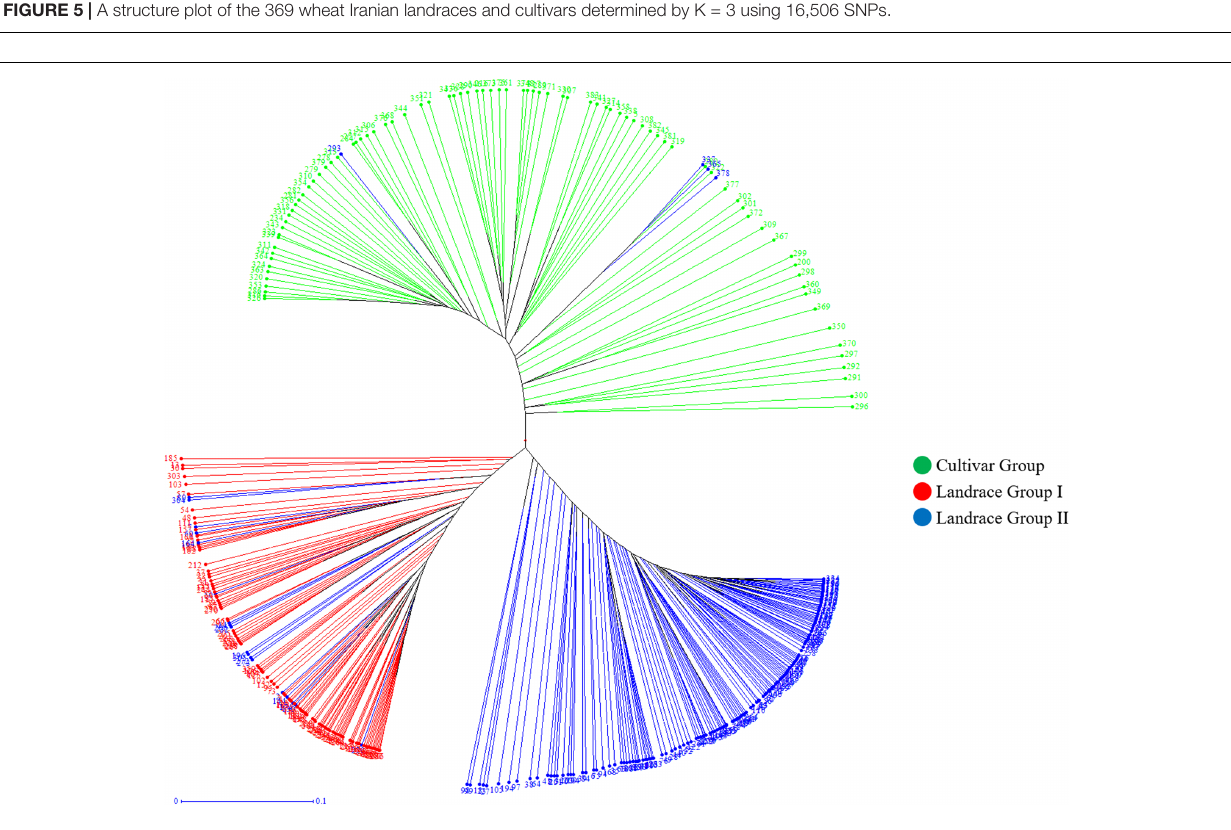
FIGURE 6 | WPGMA clustering dendrogram generated using 16506 SNPs and 369 Iranian hexaploid wheat accessions. Colors reflect groupings derived from structure